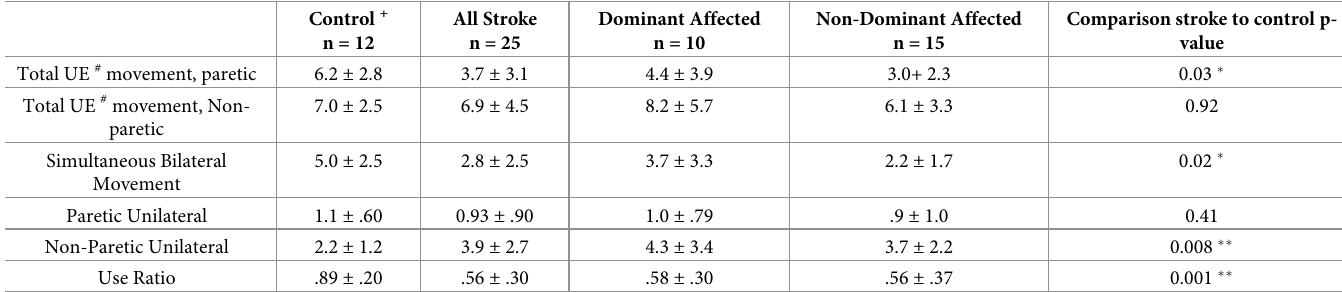
Table 2. Accelerometry